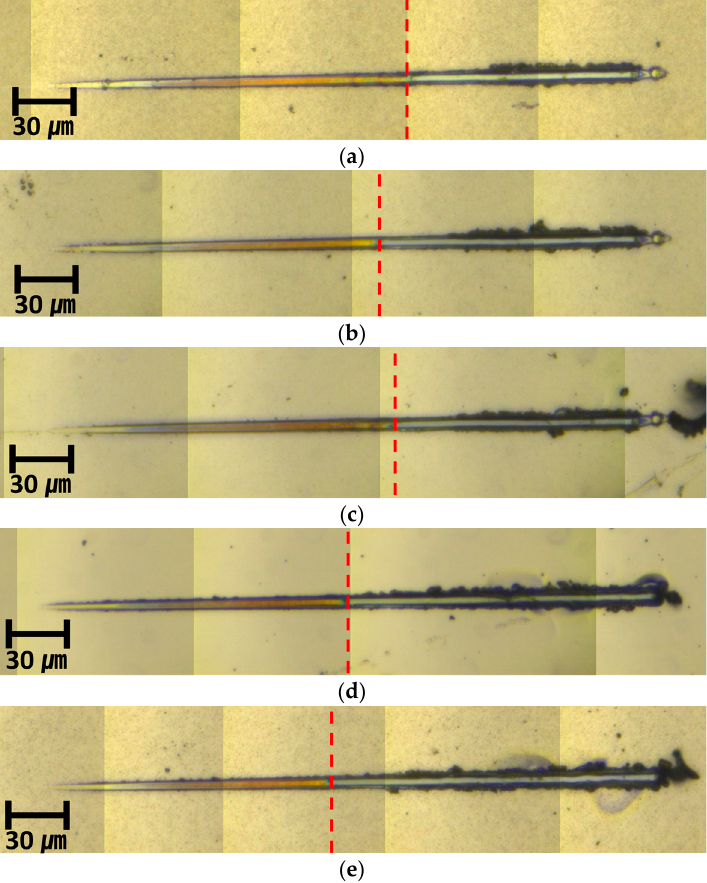
Figure 6. Nano-scratch test OM image: ( a ) 28.8 W; ( b ) 57.6 W; ( c ) 86.4 W; ( d ) 115.2 W; ( e ) 144 W. As the results in Figure 7 indicate, the critical load tends to decrease when the DC power, a deposition condition, increases.